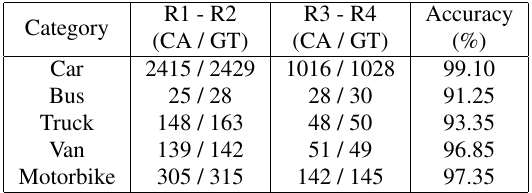
Figure 7. Test scenarios to validate the framework. Based on the experiments performed, some parameters were defined for YOLOv4, the size of the input image was set to 416 × 416 pixels, and the score and IoU detection thresholds were set to 0.6 and 0.5, respectively. The metric used to meas- ure the accuracy of the framework is shown in Equation 8.